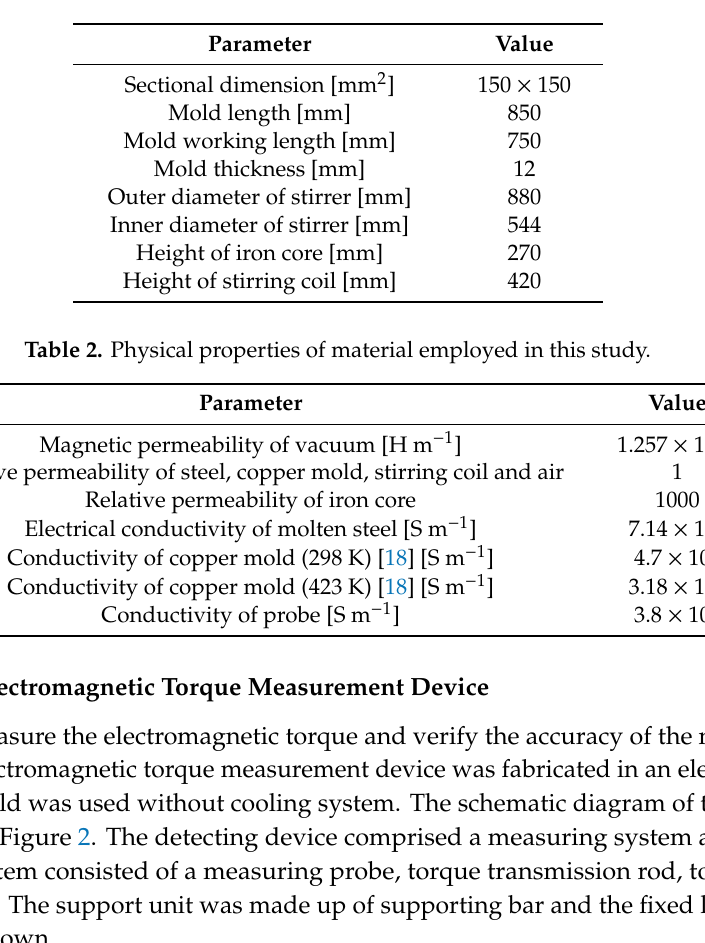
Table 1. Main dimensions of the M-EMS.